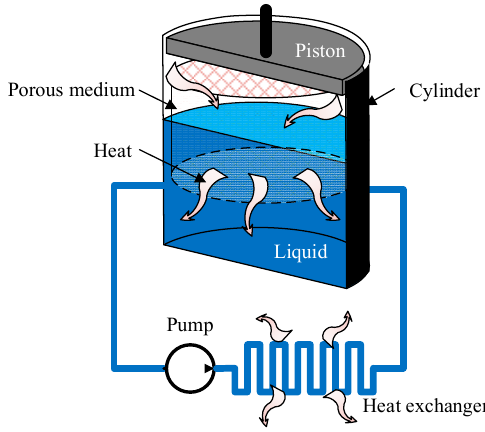
Figure 4. Isothermal principle.